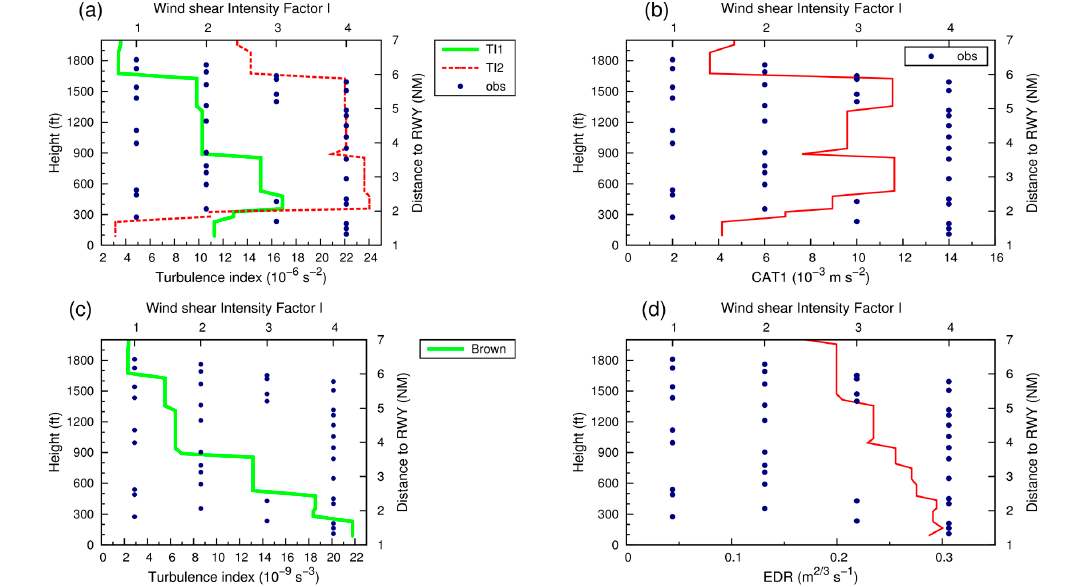
Figure 15. AROME turbulence indicators (bottom x-axis) vs. the wind shear intensity factor “I” (top x-axis), along the flight path during Flight 1. Ellrod TI1, TI2 and Brown indicators are shown in ( a ) and ( c ), respectively. Solid red lines in ( b ) and ( d ) indicate CAT1 and EDR values, respectively.